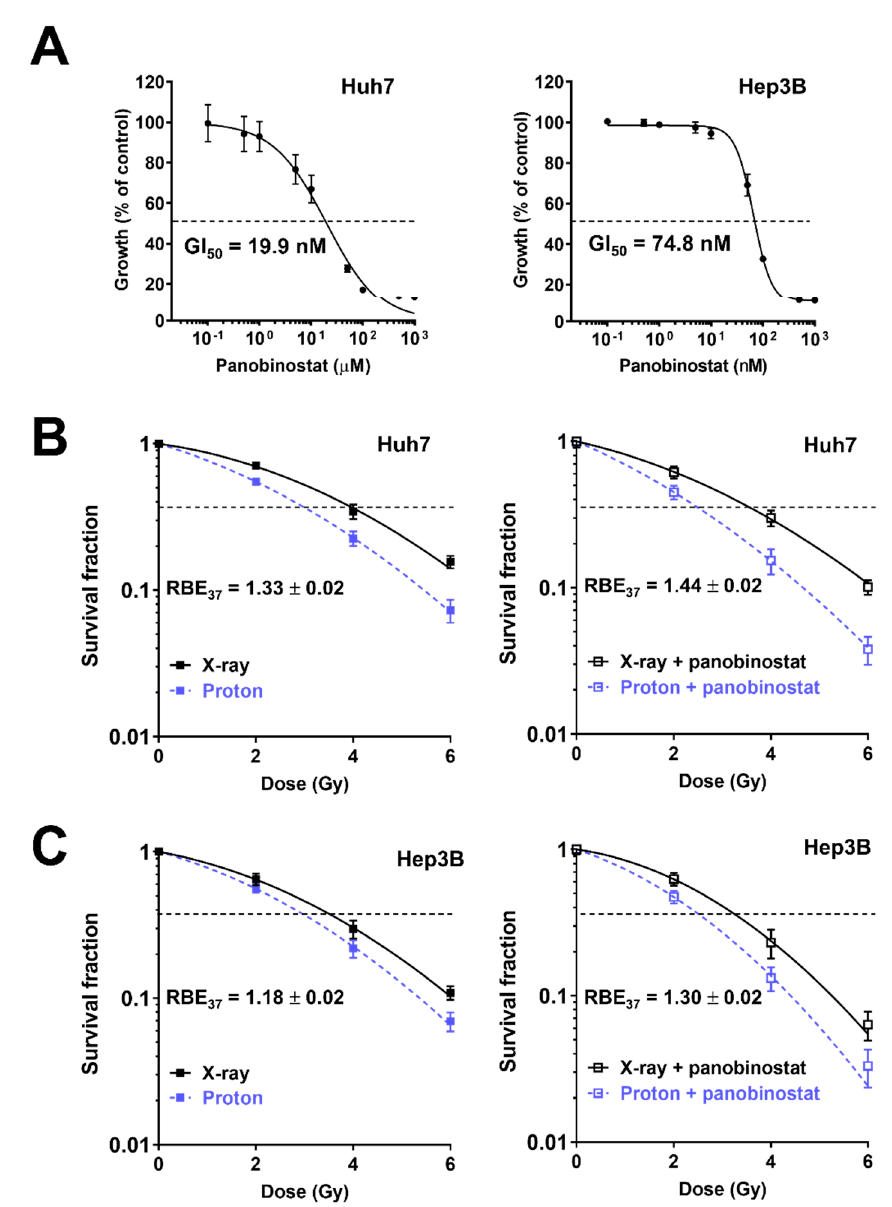
Figure 1. Effects of panobinostat combined with X-rays or protons on clonogenic survival of human hepatocellular carcinoma (HCC) Huh7 and Hep3B cells. ( A ) Dose-dependent inhibition of HCC cell proliferation by panobinostat. Huh7 and Hep3B cells were incubated with a range of concentrations of panobinostat for 72 h and their proliferation was determined by using the CCK-8 assay. The data represent the mean ± S.D. (n = 6). GI 50 , half maximum growth inhibition concentration. ( B ) Clonogenic survival curves show radiosensitizing activity of panobinostat to X-rays and protons in Huh7 cells. Huh7 cells were pre-treated with 5 nM panobinostat for 3 h, followed by irradiation with the indicated doses of X-rays or protons. Clonogenic assay was performed as described in Materials and Methods. Pre-incubation with panobinostat increased proton RBE. The data are expressed as the mean ± S.D. of three independent experiments performed in triplicate. ( C ) Pre-treatment with 10 nM panobinostat increased proton RBE in Hep3B cells. The data represent the mean ± S.D. of three independent experiments performed in triplicate.